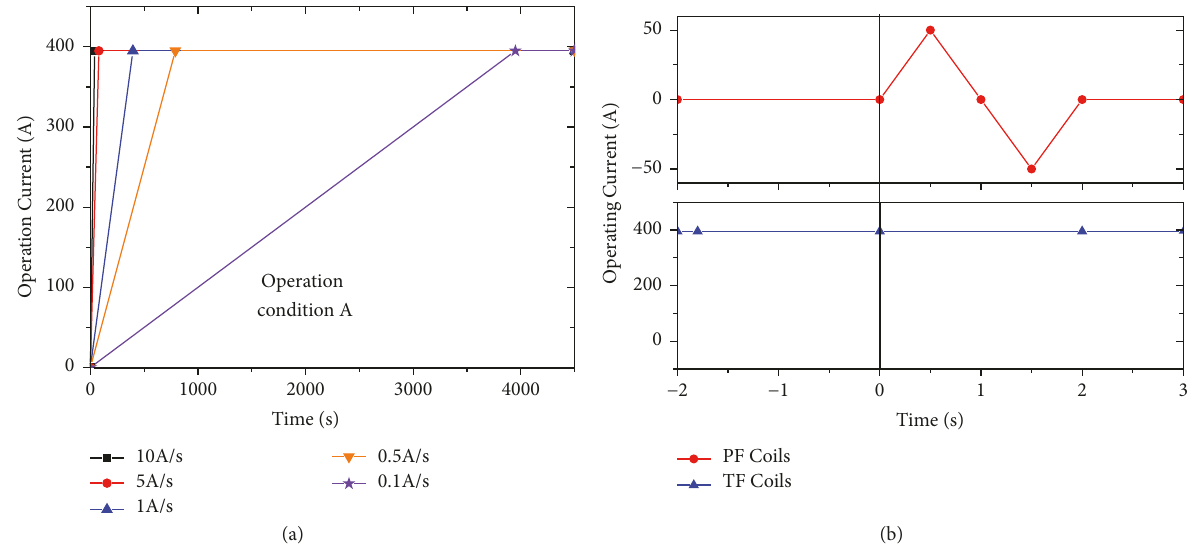
Figure 8: Operating current of PF coils and TF coils: (a) condition A: energizing process of TF coils; (b) condition B: interaction with PF coils.